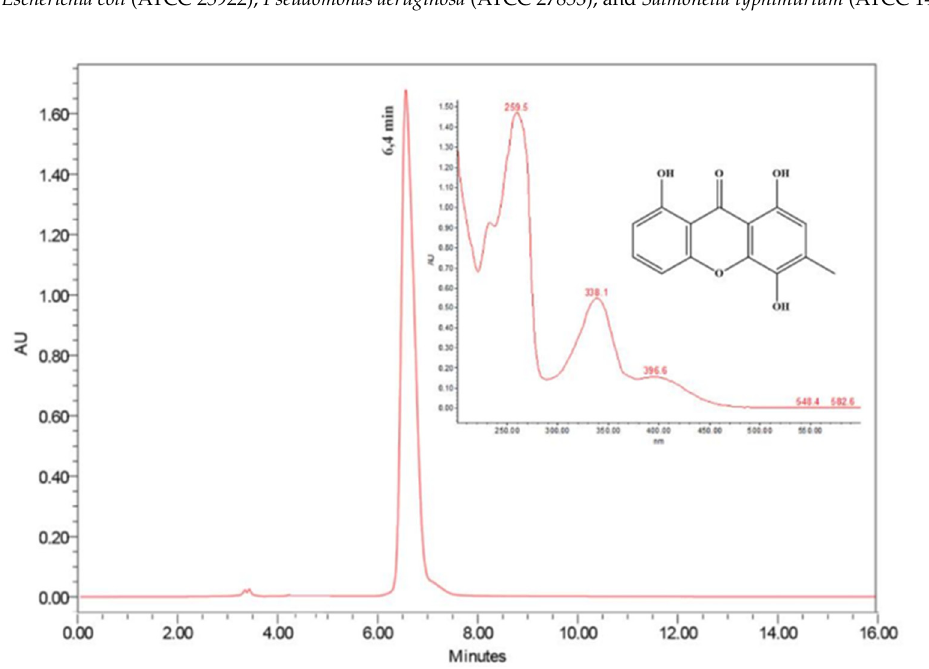
Table 2. Antiprotozoal activities of ravenelin. Table 1. Minimum inhibitory concentration (MIC) of ravenelin for Gram-negative and Gram-posi- tive bacteria.